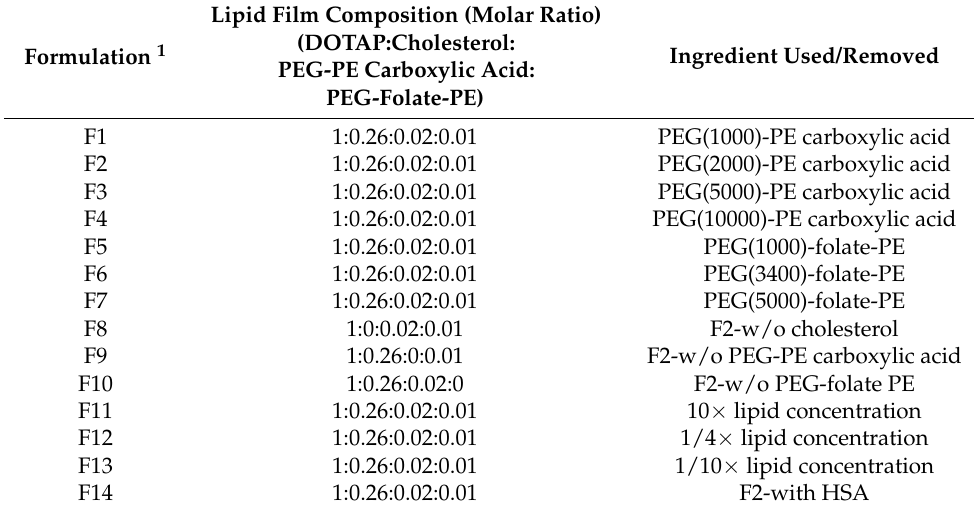
Table 1. Formulation composition for the experiments conducted for optimizing liposome formula.